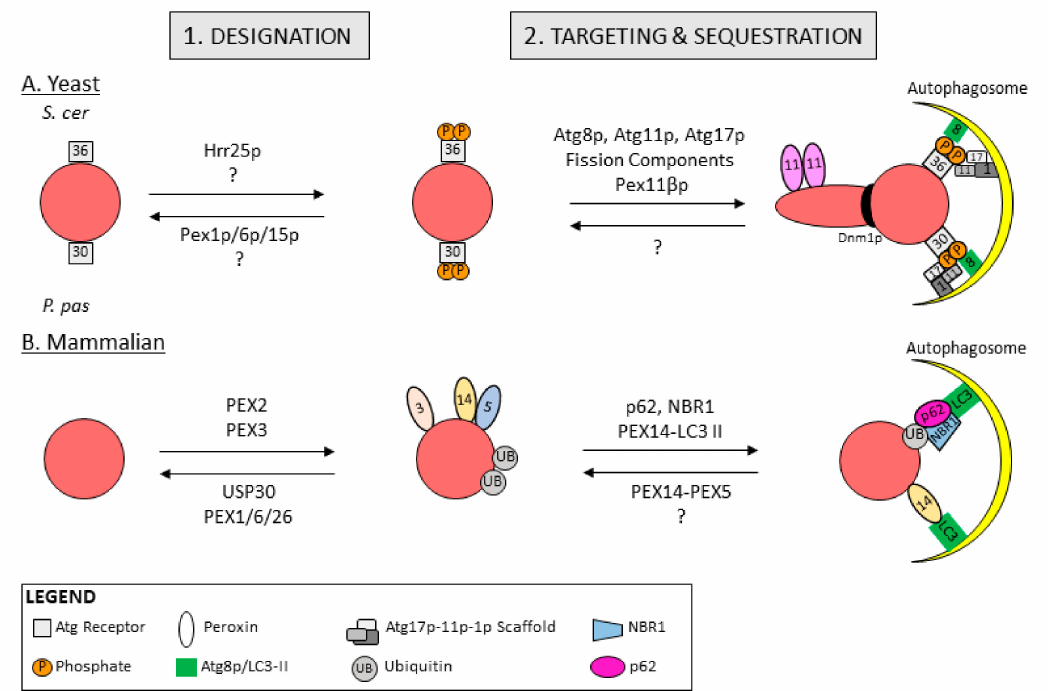
Figure 3. Schematic of pexophagy mechanisms of designation, targeting and sequestration in yeast and mammalian systems. ( A ) S. cerevisiae autophagy receptor Atg36p and P. pastoris autophagy receptor Atg30p are phosphorylated by Hrr25p and an unknown kinase to designate peroxisomes for autophagy. Phosphorylated Atg36p and Atg30p interact with sca ff olding proteins Atg11p, Atg17p and Atg1p that target them to autophagosomes. Interactions between phosphorylated Atg36p, Atg30p and Atg8p further sequester designated peroxisomes within autophagosomes. Pex11 β p-mediated fission further aids peroxisome sequestration within the autophagosome. ( B ) Peroxisome membrane proteins are ubiquitinated by the E3 ubiquitin ligase, PEX2, to designate peroxisomes for pexophagy. Ubiquitinated peroxisome membrane proteins are removed from peroxisomes by the AAA-type ATPase PEX1-PEX6-PEX26 and the deubiquitinase USP30 to prevent pexophagy. Increasing expression of PEX3 on peroxisome membranes may also designate them for pexophagy. Ubiquitinated peroxisomes are targeted to autophagosomes through interactions with the autophagy receptors NBR1 and p62, which facilitate sequestration within autophagosomes through binding with LC3-II. Peroxisomes are also targeted and sequestered within autophagosomes when LC3-II out-competes PEX5 for binding to